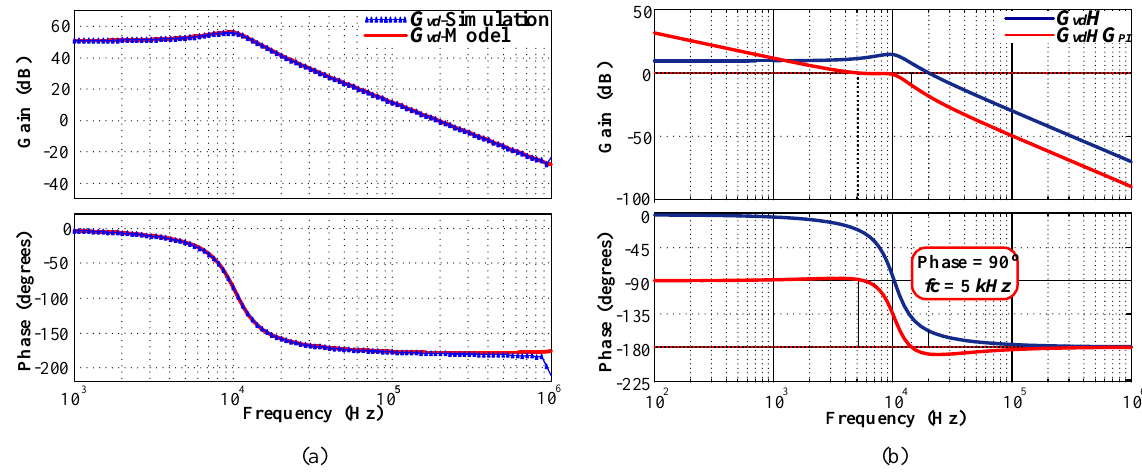
Figure 6. Bode diagram: ( a ) Validation of transfer function G vd ( s ) ; ( b ) open-loop transfer-function. In this regard, by using the design specifications from Table 1, the bode diagram of the transfer function G vd , including the gain sensor H = 8.33 × 10 − 3 V/V, is illustrated in Figure 6b (blue curve). The average voltage-mode control technique is applied to the regulation of the output voltage of the converter and, due to the characteristic of the control-to-output transfer function, the PI controller was adopted. The conventional phase-margin and gain-margin stability criteria are applied, where a crossing frequency is around 1/4 and 1/10 of the switching frequency, and a phase margin 45° ≤ PM ≤ 90° should be attended to provide a good response with an adequate output-voltage overshoot. As shown in Figure 6 (red in color), by using a proportional gain K p = 0.1033 and an integral gain K i = 7944 for the controller PI, the crossover frequency and phase margin obtained from the voltage control loop are 5 kHz and 90°,